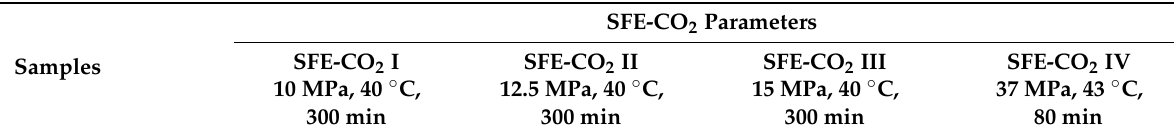
Table 4. Bitter acid, chlorophyll and carotenoid content of Ella hop SFE-CO 2 extracts obtained under the different experi- mental